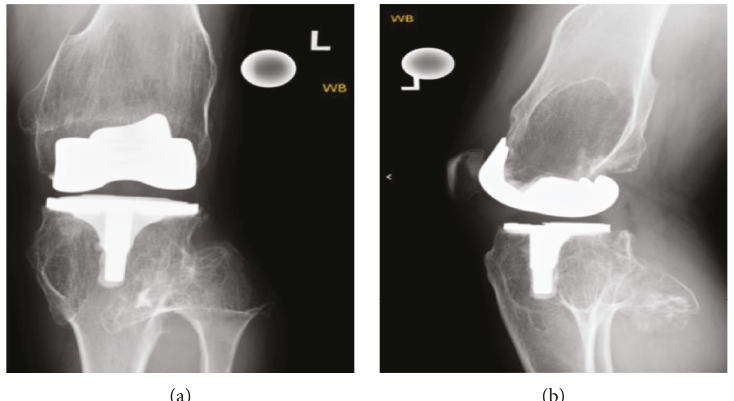
Figure 2: A two-month postoperative AP and lateral X-ray view of the patient ’ s left knee displaying a Smith & Nephew posterior stabilized prosthesis with unchanged osteochondroma formation.